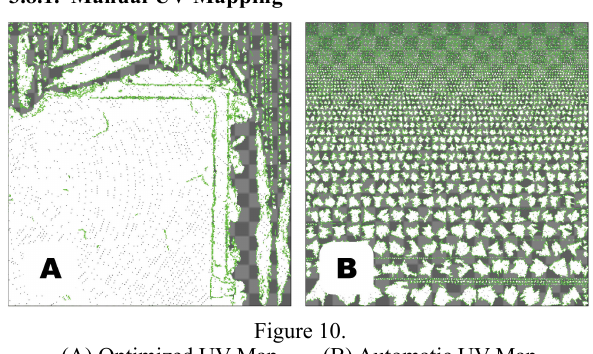
Figure 10. (A) Optimized UV Map (B) Automatic UV